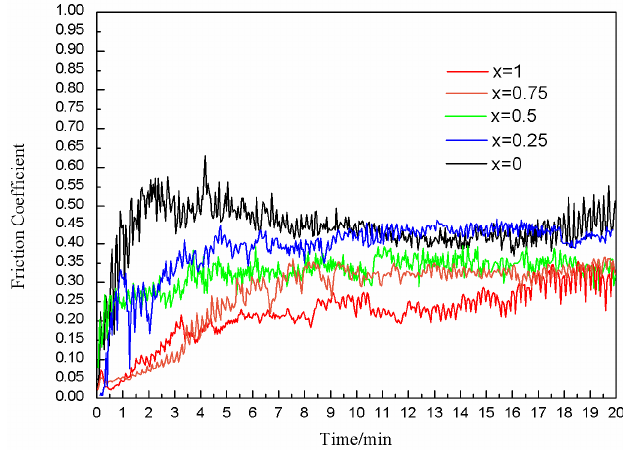
Figure 5. Friction coefficient of coating.